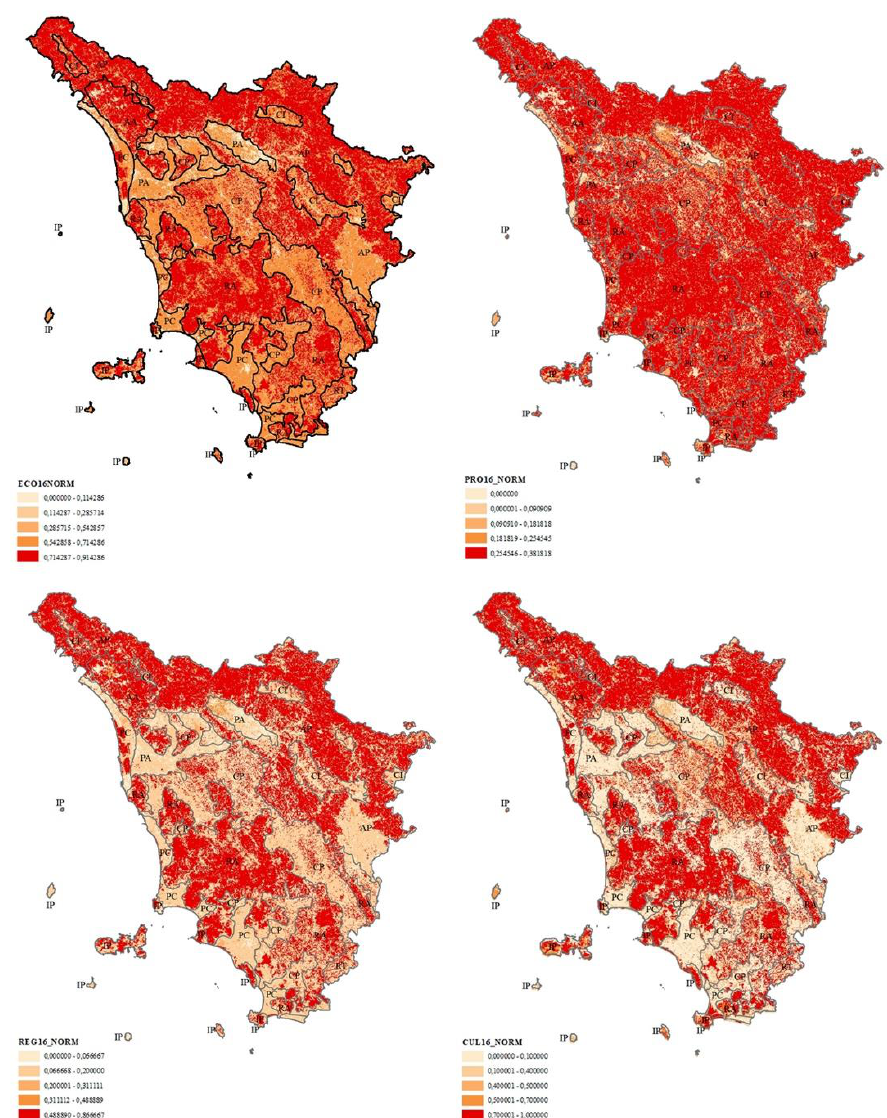
Figure 4. The measurement of ecosystem services in 2016 (normalized values). In the top left-hand corner: support service (ecological integrity); in the top right-hand corner: provisioning service; bottom left-hand corner: regulation service; bottom right-hand corner: cultural service. Table 3. Contribution of different type of landscape systems to the provision of ecosystem services (support, provisioning, regulating, cultural- recreational).